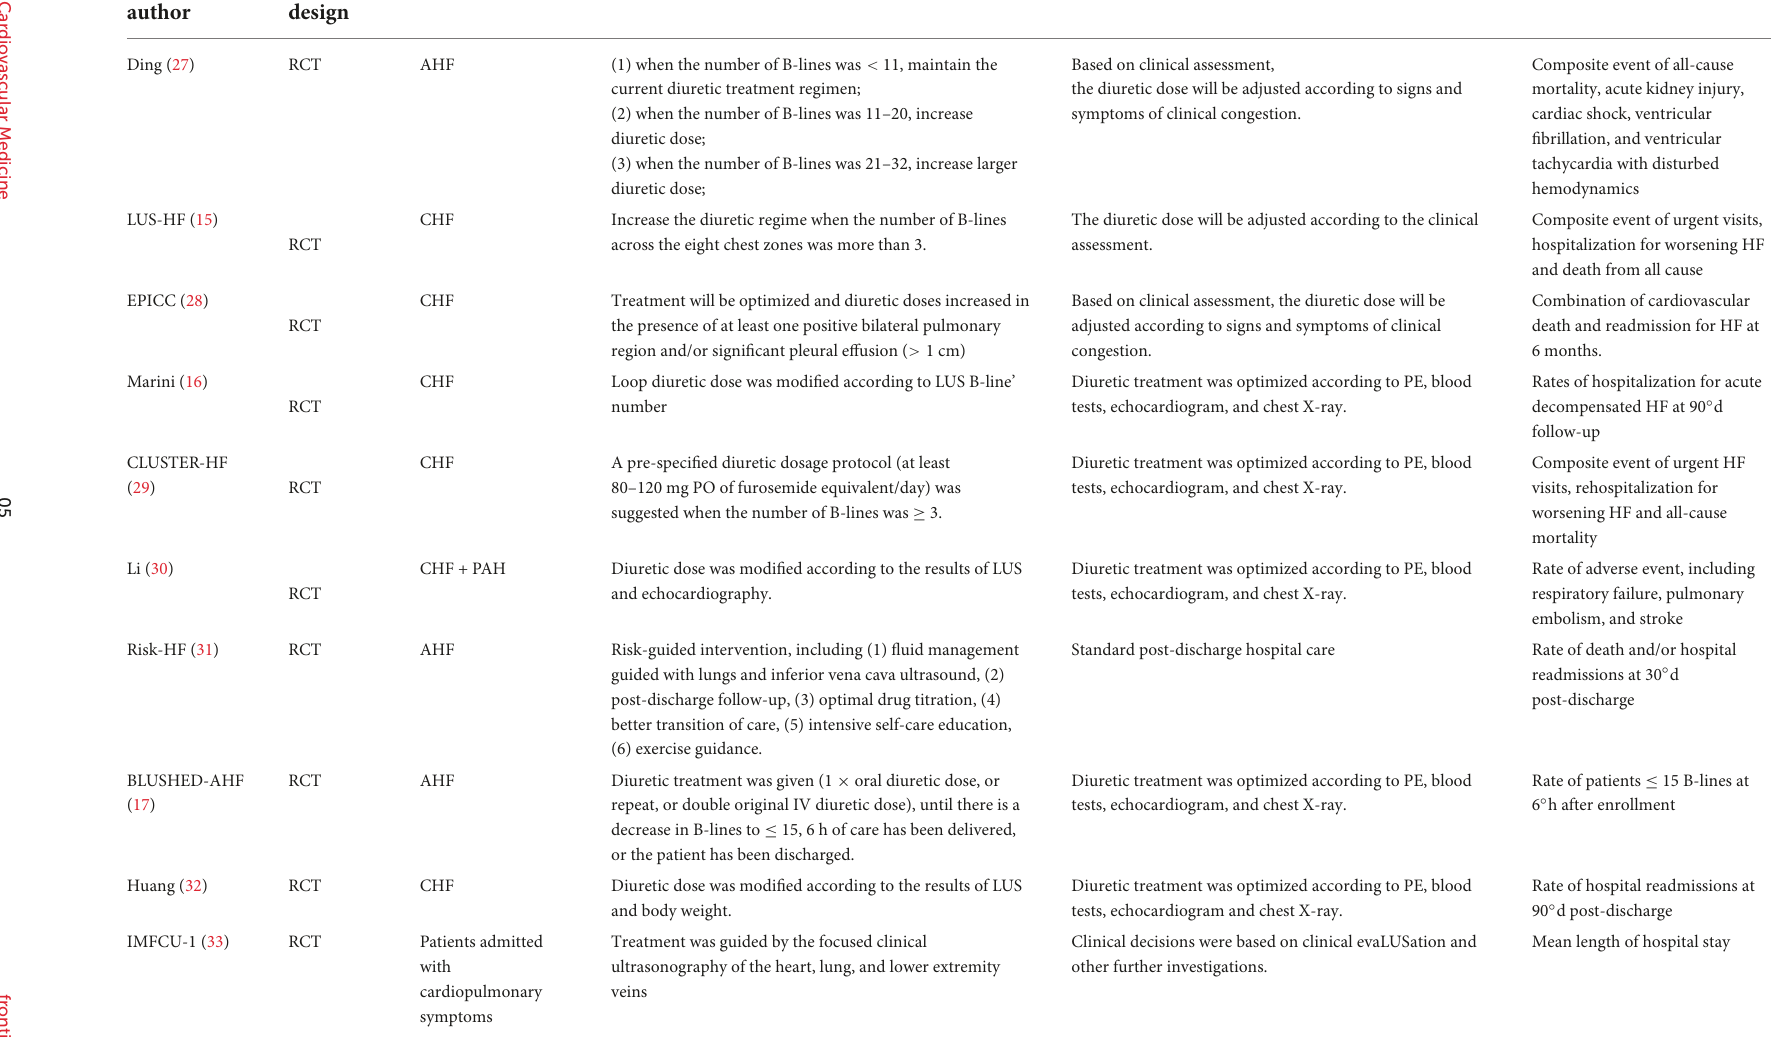
TABLE 1 Baseline characteristics of the included randomized controlled